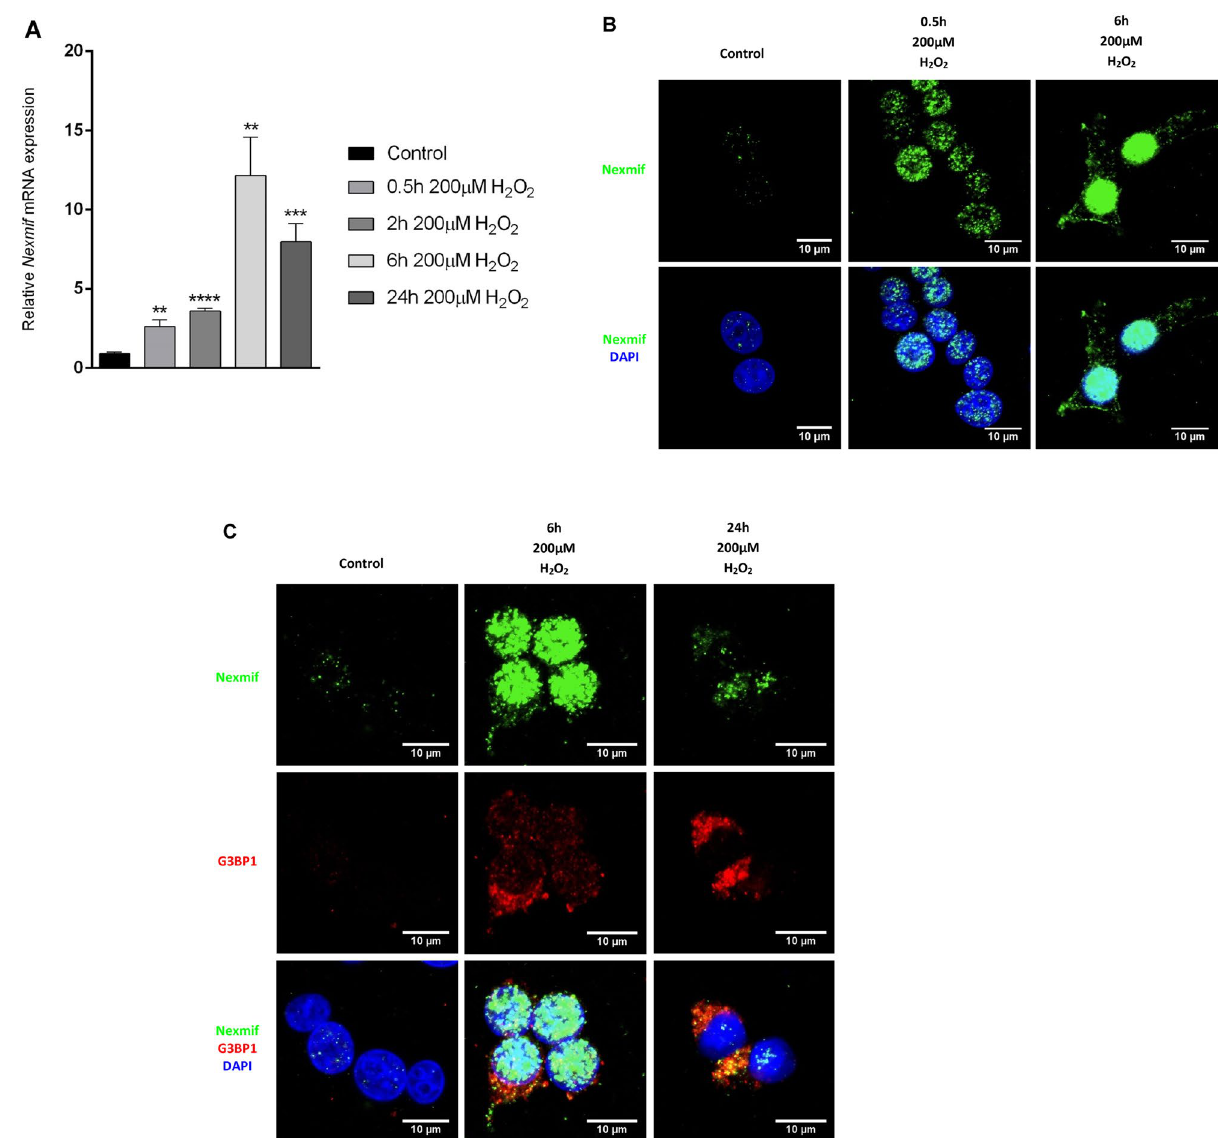
Figure 5. Nexmif expression in reaction to oxidative stress in INS-1E cells. ( A ) Nexmif mRNA expression over a time course in response to 200 µM H 2 O 2 at time points 0 h, 0.5 h, 2 h, 6 h, and 24 h (n = 3). Error bars indicate the standard deviation. Two-tailed unpaired Student t-test: * P ≤ 0.05, ** P ≤ 0.01, *** P ≤ 0.001, **** P ≤ 0.0001. ( B ) Nexmif localization (green) in INS-1E cells challenged with 200 µM H 2 O 2 over a time course of 0 h, 0.5 h, and 6 h by immunofluorescence. DAPI (blue). ( C ) Expression and co-localization of Nexmif (green) by fluorescent in situ RNA hybridization (FISH) with G3BP1 (red) in INS-1E cells, marking stress granules by